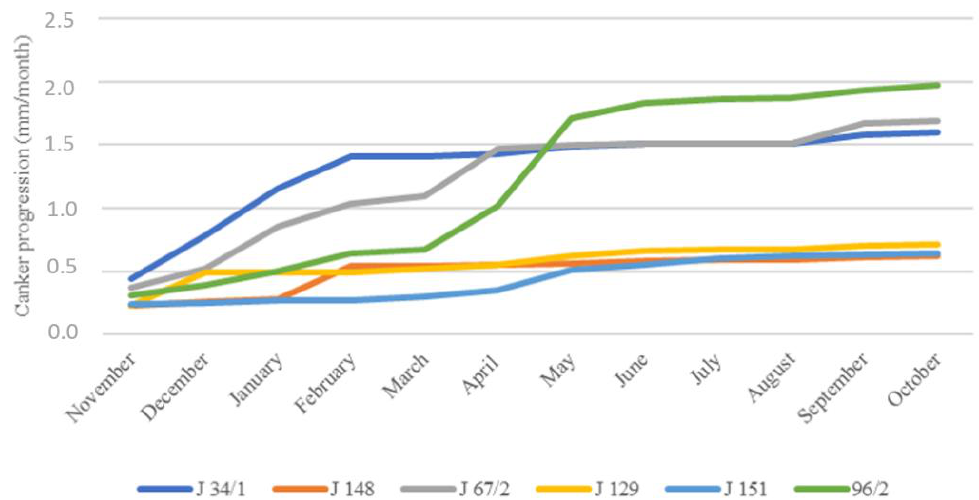
Figure 3. Two type of symptoms caused by Neofabraea sp. on apple branches: ( a ) developed canker caused by isolate J129; ( b ) canker with visible conidiomata under surface of branches caused by isolate J67/2. Pictures were taken 10 months post inoculation.